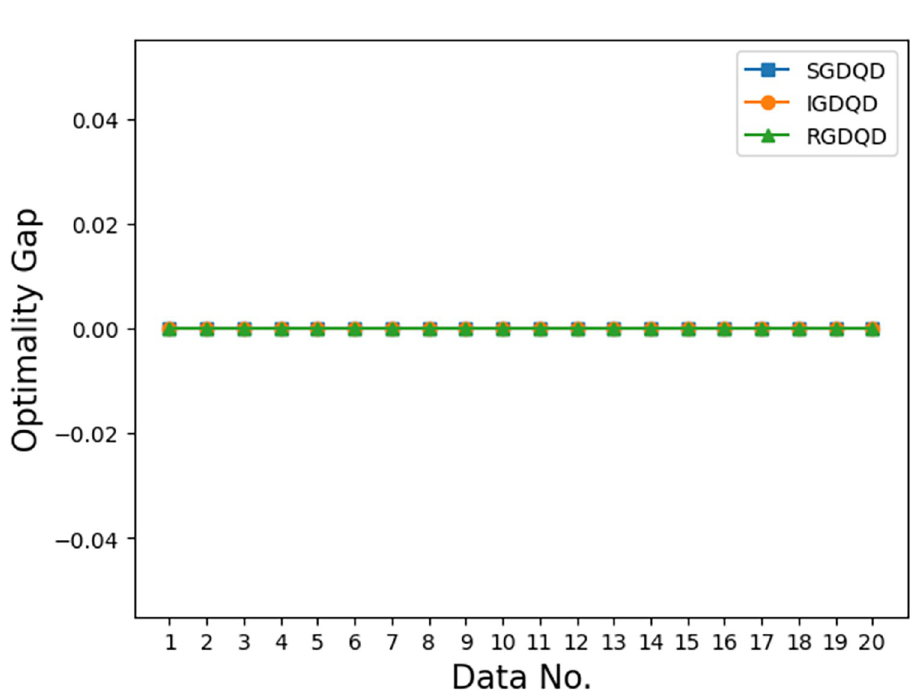
Fig 7. Comparison of optimality gaps for Q =